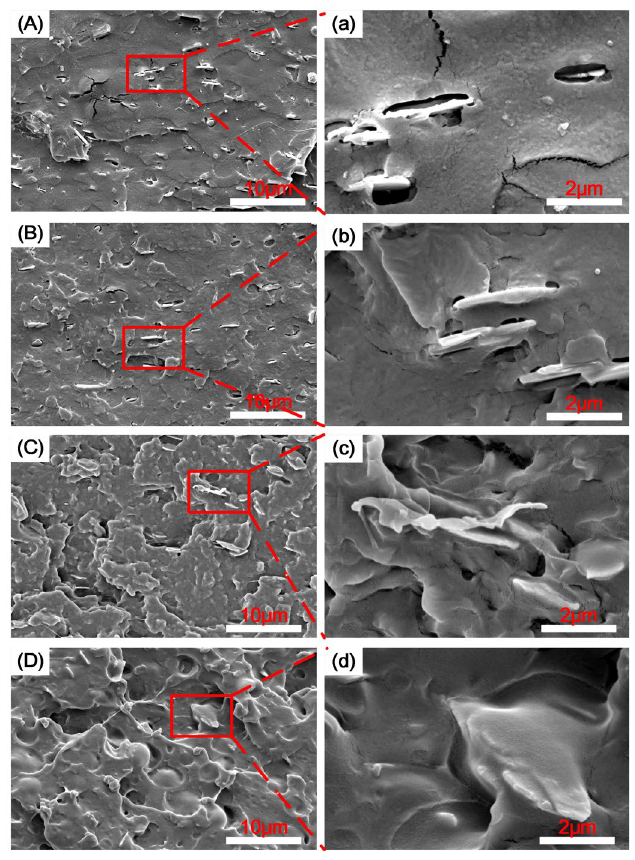
Figure 2. SEM micrographs of impact sections of PLA/ZrP/E − MA − GMA (wt/wt/wt) nanocomposites: ( A ) 97/3/0, ( B ) 92/3/5, ( C ) 82/3/15, and ( D ) 72/3/25. ( a – d ) are enlarged micrographs of ( A – D ), respectively.